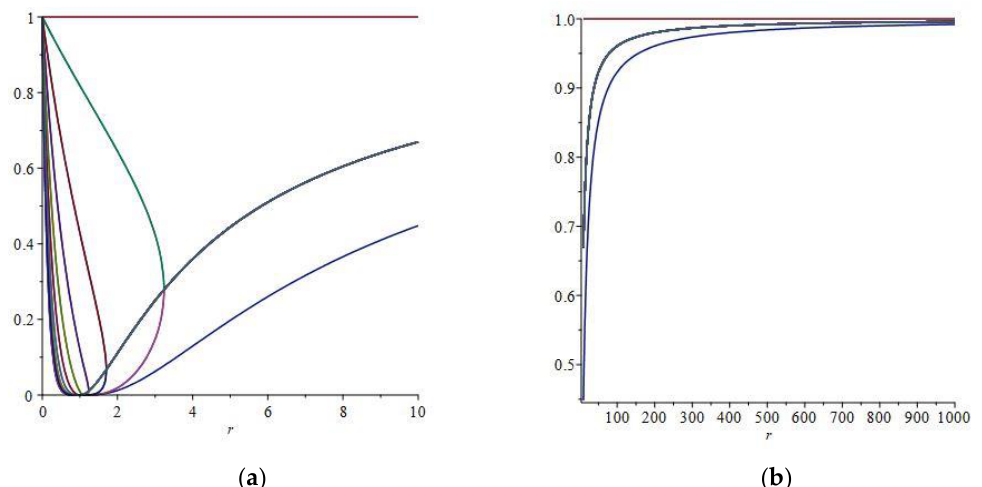
Figure 11. The graphs of the eigenvalues of H vs. mesh ratio functions for the S4 (0, ½, ½, ½, 1) algorithm for N = 20. ( a ) r ∈ [ 0, 10 ] ( b ) r ∈ [ 10, 1000 ]